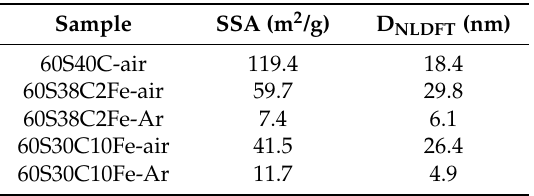
Table 4. Textural parameters obtained by N 2 adsorption–desorption porosimetry for the calcined sol-gel